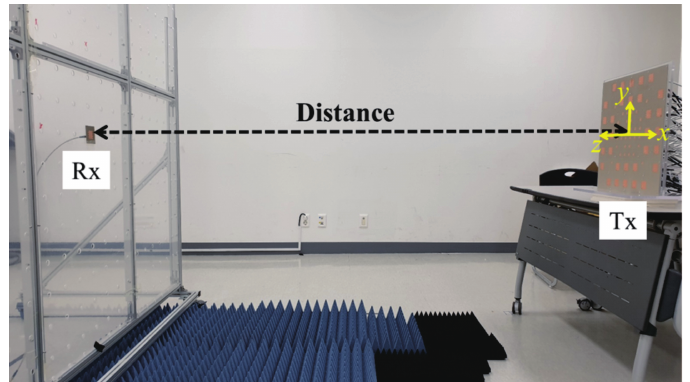
Figure 14. RF WPT experimental set-up (1): according to the transmission distance.